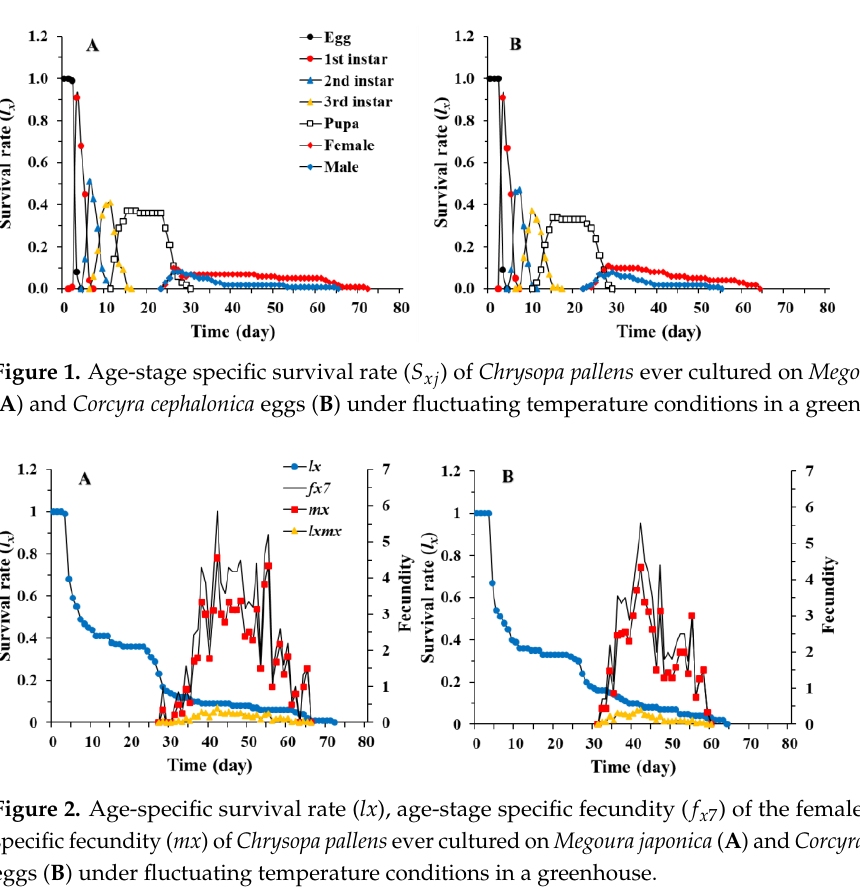
Insects 2021 , 12 , x FOR PEER REVIEW